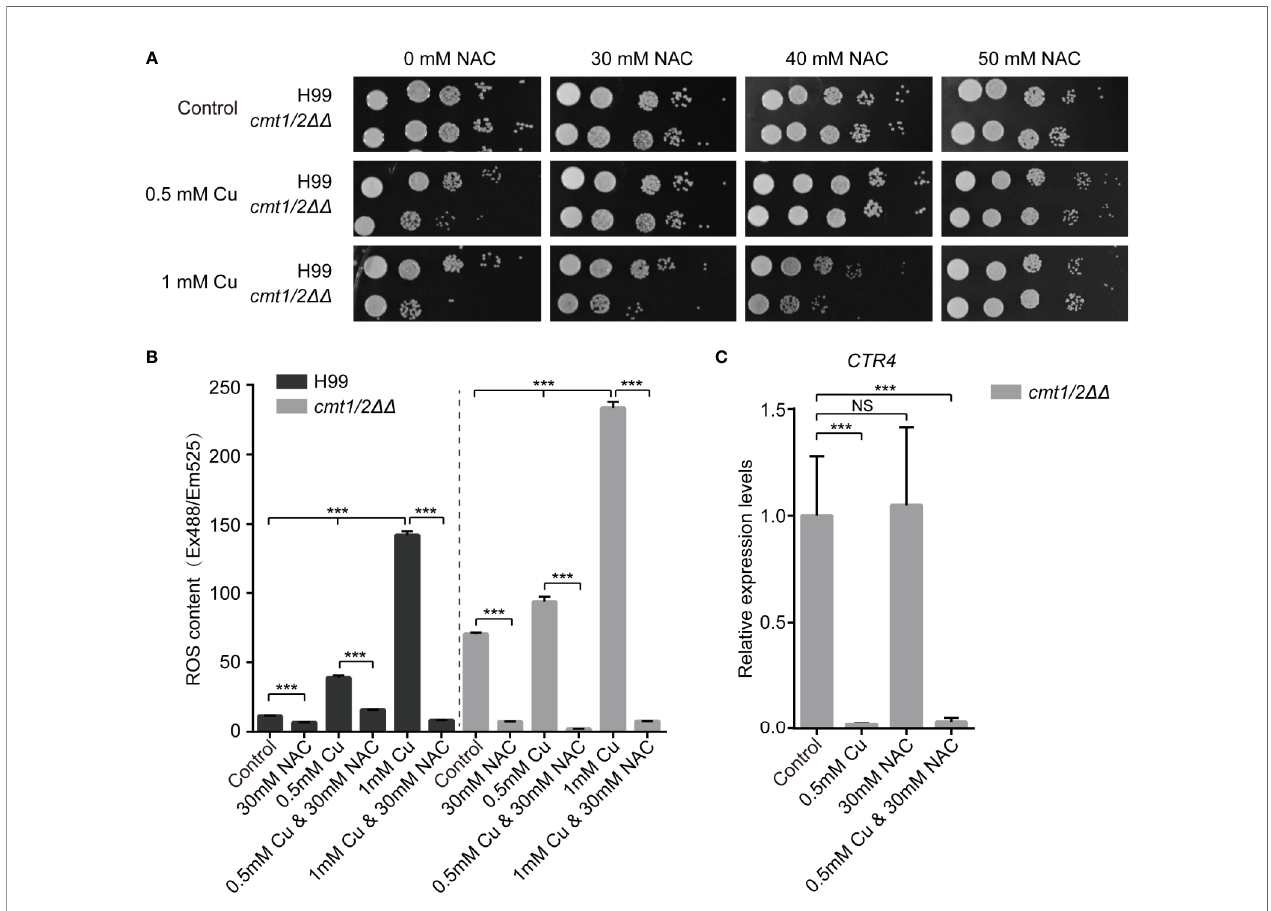
FIGURE 1 | N-acetylcysteine reduces the ROS-toxicity induced by copper in Cryptococcus neoformans . (A) Growth of C neoformans following treatment with Cu and N-acetylcysteine (NAC). Clinically isolated wild-type C. neoformans strain H99 and the Cu-sensitive mutant cmt1/2 DD were grown in yeast extract peptone dextrose (YPD) liquid medium overnight, serially diluted and cultured on agar medium at 30°C for 2 days. (B) Levels of intracellular ROS following treatment with Cu and NAC. Cells were treated with 0.5 or 1mM Cu and NAC was added to scavenge ROS. The intracellular ROS level is shown as fl uorescence intensity (Ex488/Em525) divided by the absorbance at 600 nm. *** p -value <0.005 ( n =3). (C) Relative expression of the Cu importer CTR4 in the Cu-sensitive mutant cmt1/2 DD . Cells were treated with 0.5 mM Cu and/or 30 mM NAC and RNA was extracted and analyzed by real-time polymerase chain reaction. *** p -value <0.005 ( n =3). NS , not signi fi